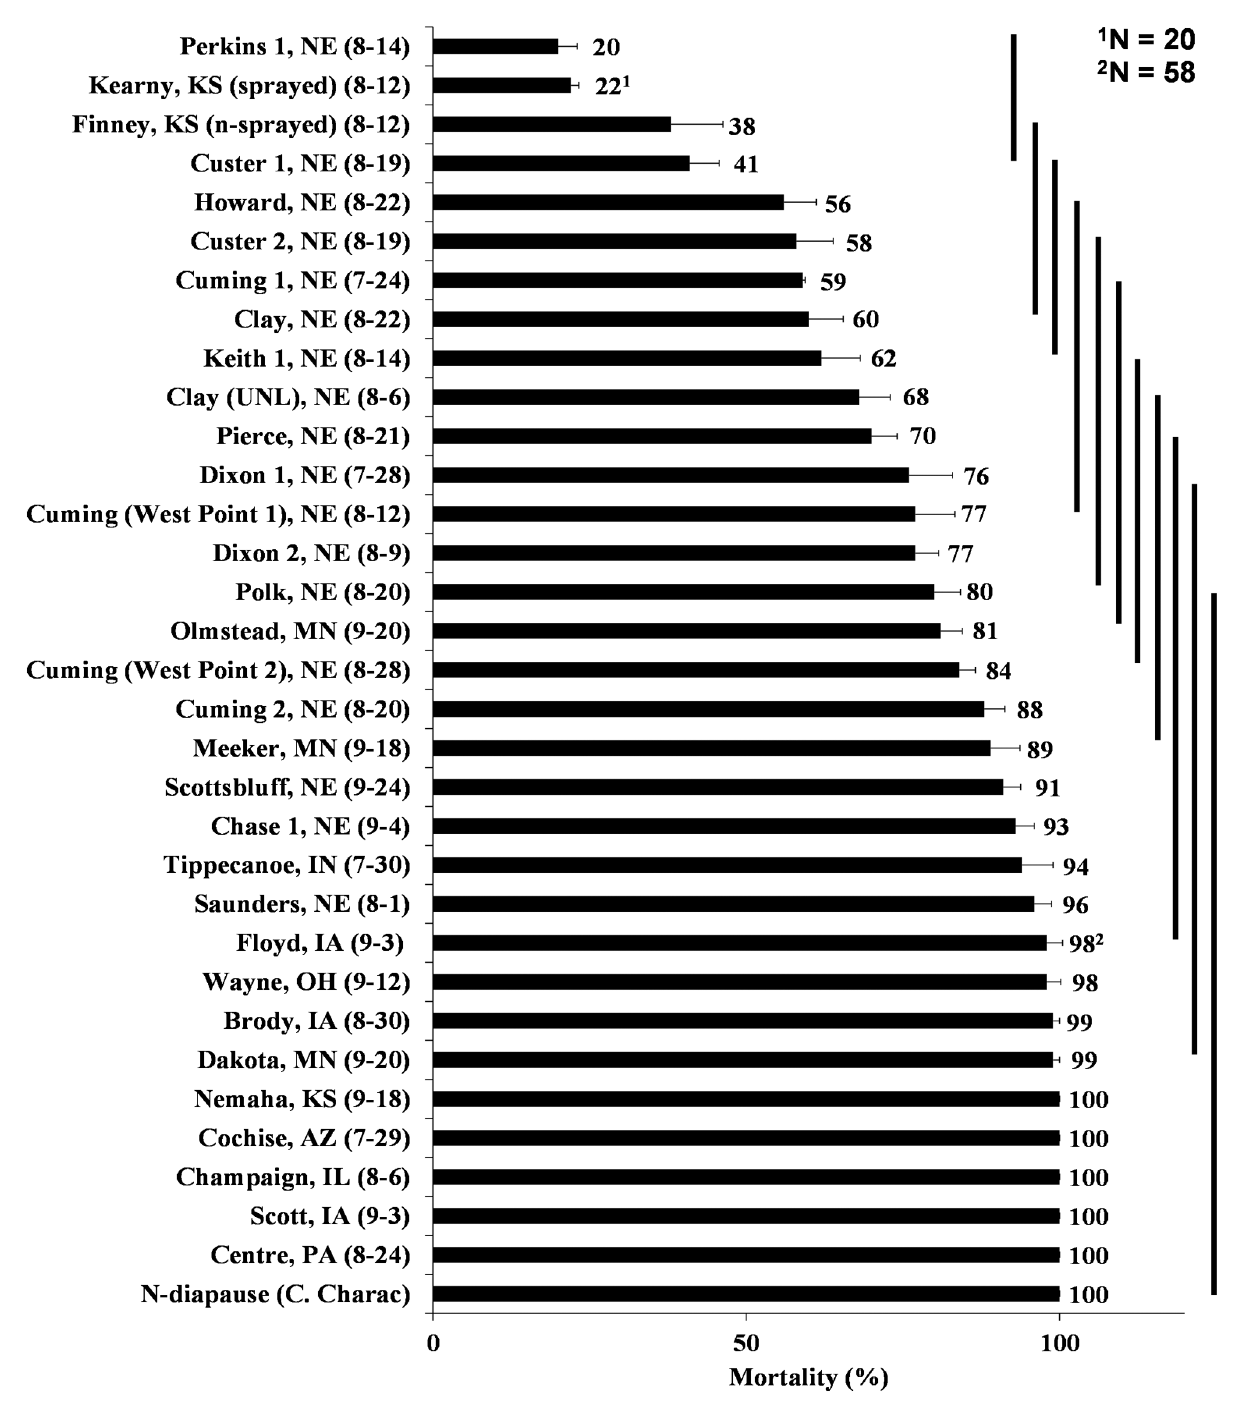
Fig 2. WCR adult mortalities of 32 different field populations from counties throughout the U.S. Corn Belt collected in 2013 (collection date) plus a susceptible laboratory population (non-diapause, Crop Characteristics 1 ) after exposure to diagnostic concentration of bifenthrin (0.77 μ g of bifenthrin/vial) corresponding to the LC 99 calculated from 10 WCR lab populations. Means and standard errors are result of 10 replicates (vial), with 10 beetles per vial (unless otherwise stated). Means and standard errors are the result of 10 replicates (vials) with 10 beetles per vial (unless otherwise stated). Population means encompassed by the same solid vertical bars are not significantly different and were compared by least squared means with Tukey adjustment at p (cid:1) 0.05 using PROC GLIMMIX in SAS 9.3.